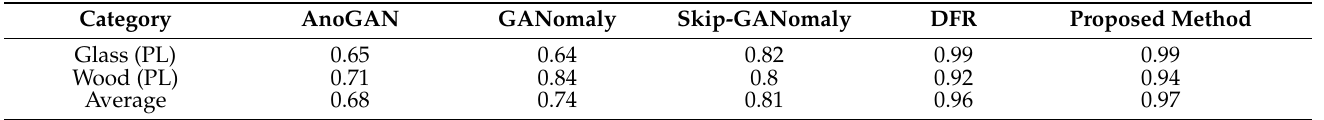
Table 3. AUCs of production line datasets using AnoGAN, GANomaly, Skip-GANomaly, and the proposed